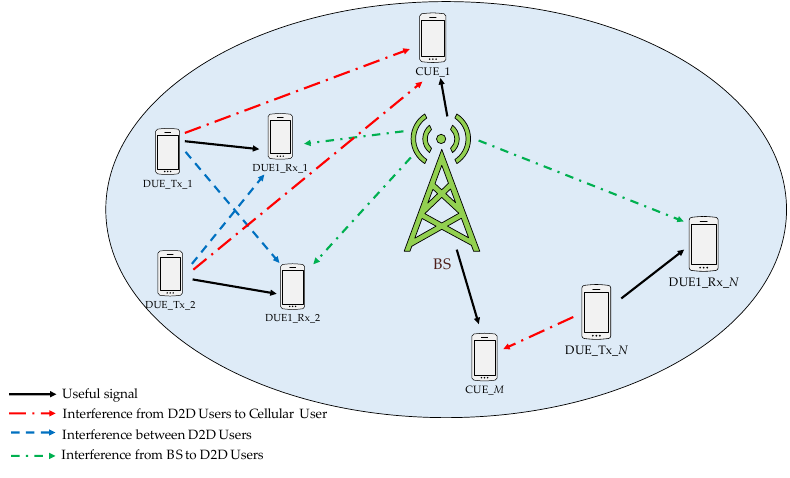
Figure 1. Proposed system model.